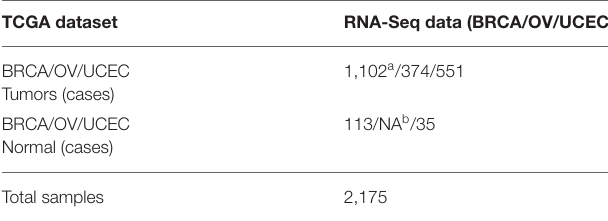
TABLE 1 | Summary of TCGA dataset handling used in this